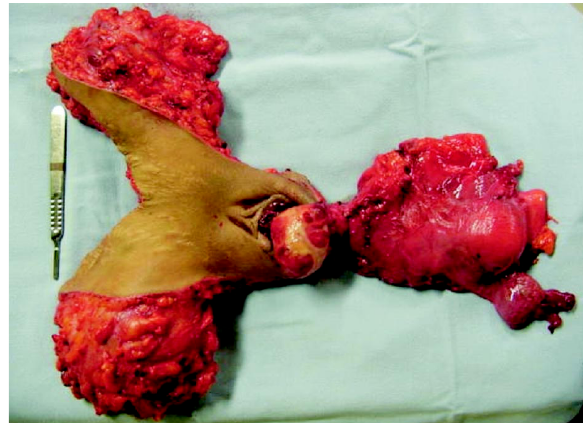
Figure 2 – Surgical specimen with in bloc bilateral inguinal lymph nodes, vulvectomy and anterior pelvic exenteration.